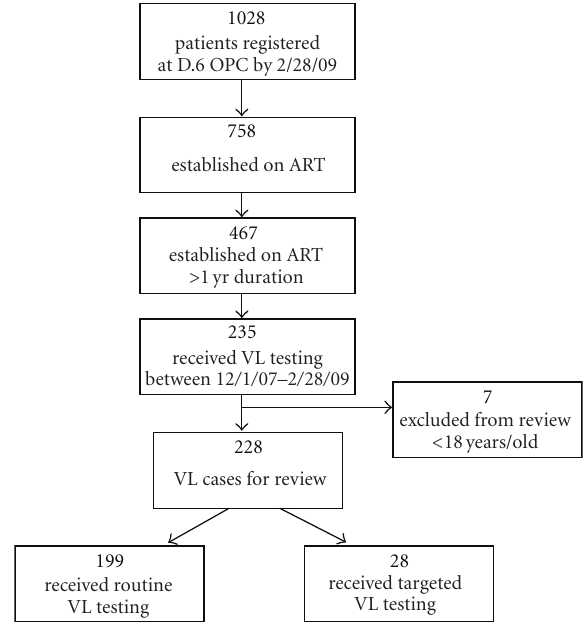
Figure 1: Flow chart of adult patients on ART > 1yr who received VL testing and enrolled for review.